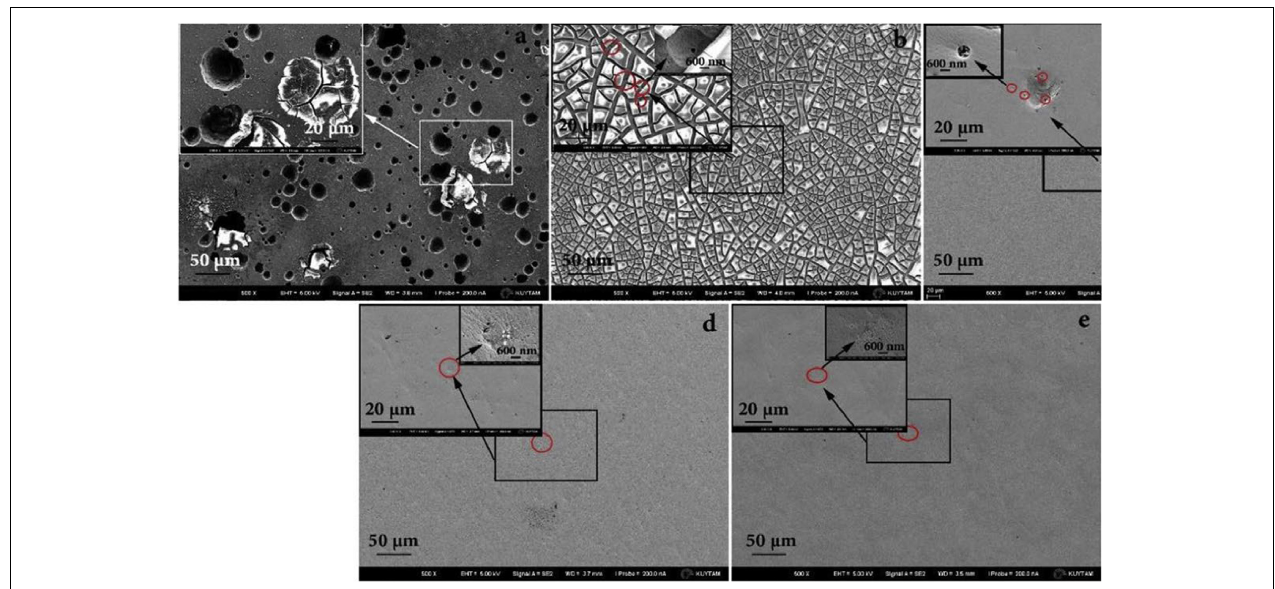
FIGURE 4 | FESEM images of different alloys after the potentiodynamic tests in PBS electrolyte at 37 ◦ C. (a) 316L, (b) CoCrMo alloy, (c) Ti6Al4V, (d) TiZrTaHfNb HEA, and (e) Ti 1 . 5 ZrTa 0 . 5 Hf 0 . 5 Nb 0 . 5 HEA (Motallebzadeh et al., 2019). Reproduced from Motallebzadeh et al. (2019) with